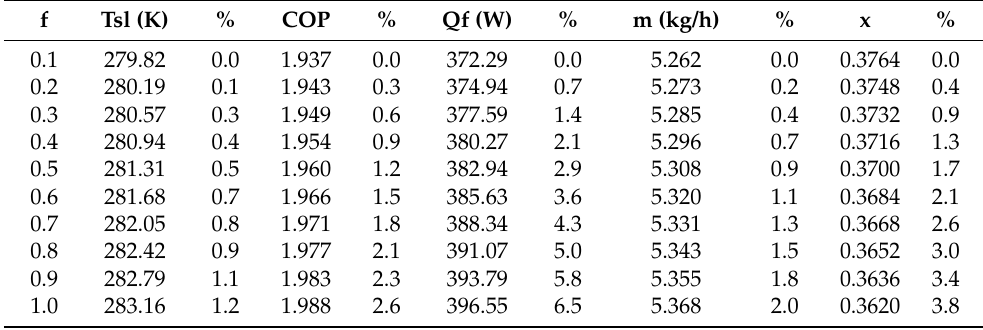
Table 1. Sensitivity analysis with respect to lateral heat transfer area. T cond = 54 °C, T evap = − 3.7